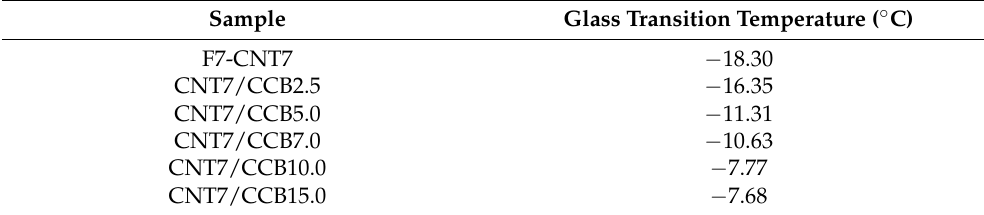
Figure 8. Storage modulus ( A ) and tan δ ( B ) as functions of temperature of ENR-FeCl 3 filled with CNTs (F7-CNT7) and CNT-CCB hybrid fillers with various CCB loadings at 2.5, 5.0, 7.0, 10.0 and 15.0 phr. Table 6. Glass transition temperature ( T g ) of ENR-50 compounded with FeCl 3 and (ENR–FeCl 3 ) mixed with CNTs (F7-CNT7) and CNT–CCB hybrid fillers.